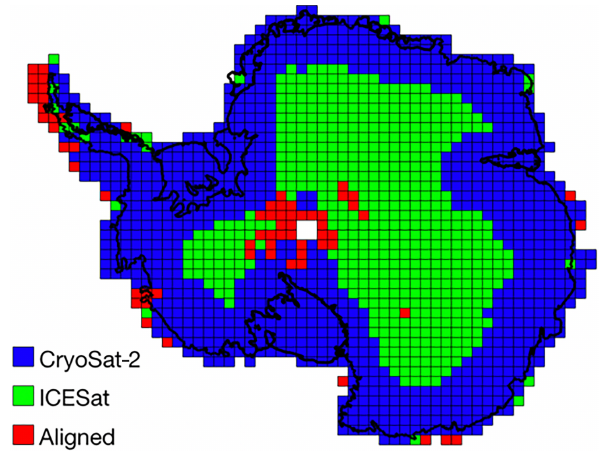
Figure 3. Map of the registration data source for each 100km by 100km REMA